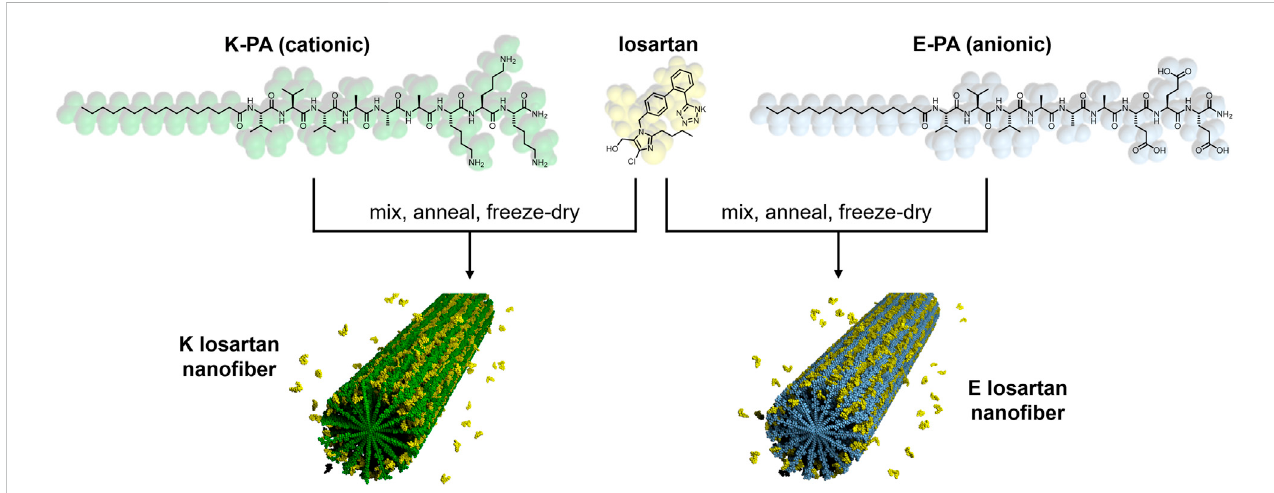
FIGURE 1 Chemical structure and schematic of losartan sustained release PA nano fi bers. Positively charged K-PA (green) and negatively charged E-PA (light blue) are co-assembled in water with losartan (yellow) to form K losartan nano fi bers and E losartan nano fi bers, respectively.